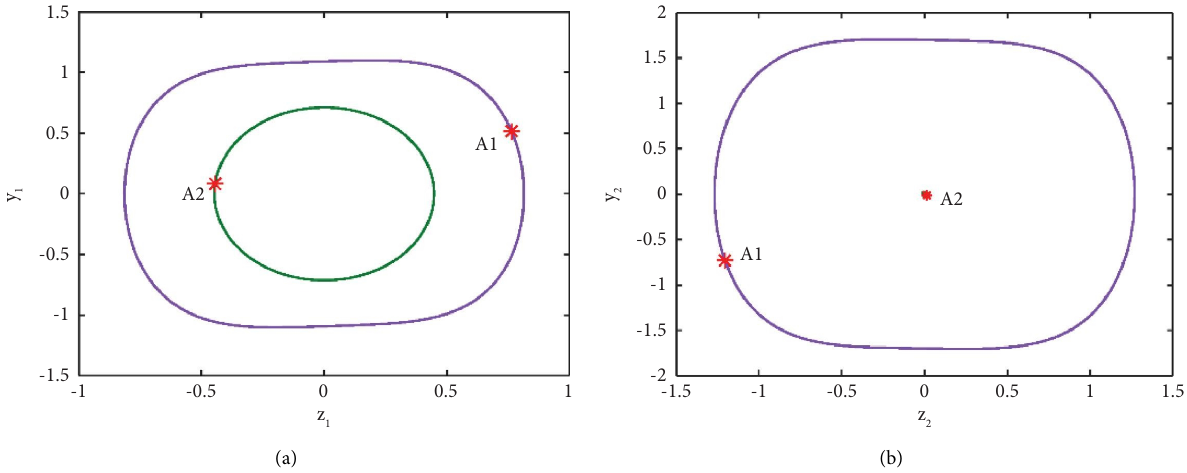
Figure 3: Te phase trajectories of the diferent attractors. (a) Te mechanical equipment vibration response. (b) Te NES vibration response.